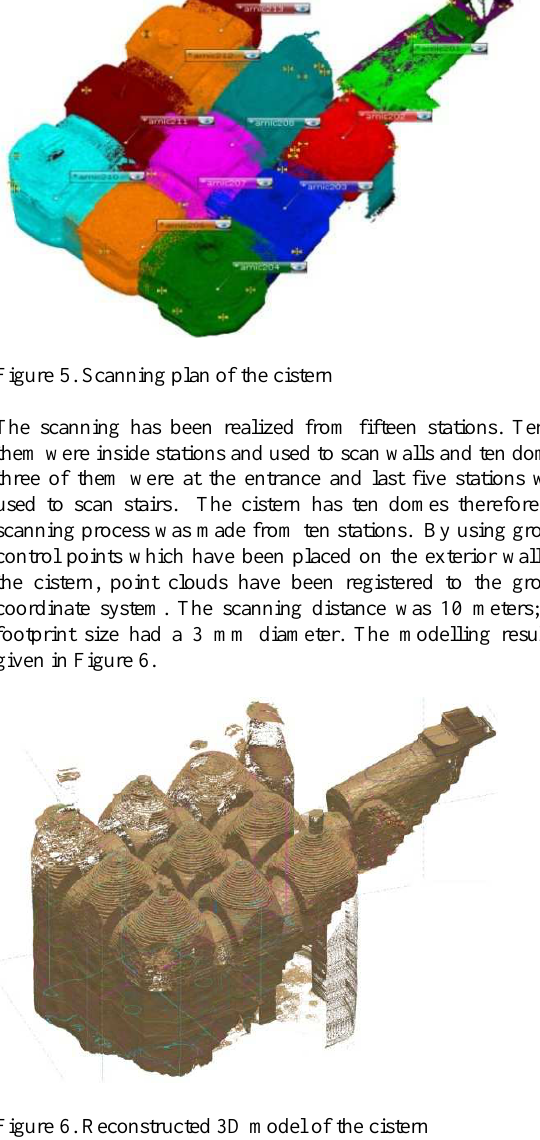
Figure 6. Reconstructed 3D model of the cistern Due to density of the point cloud, processing can be time